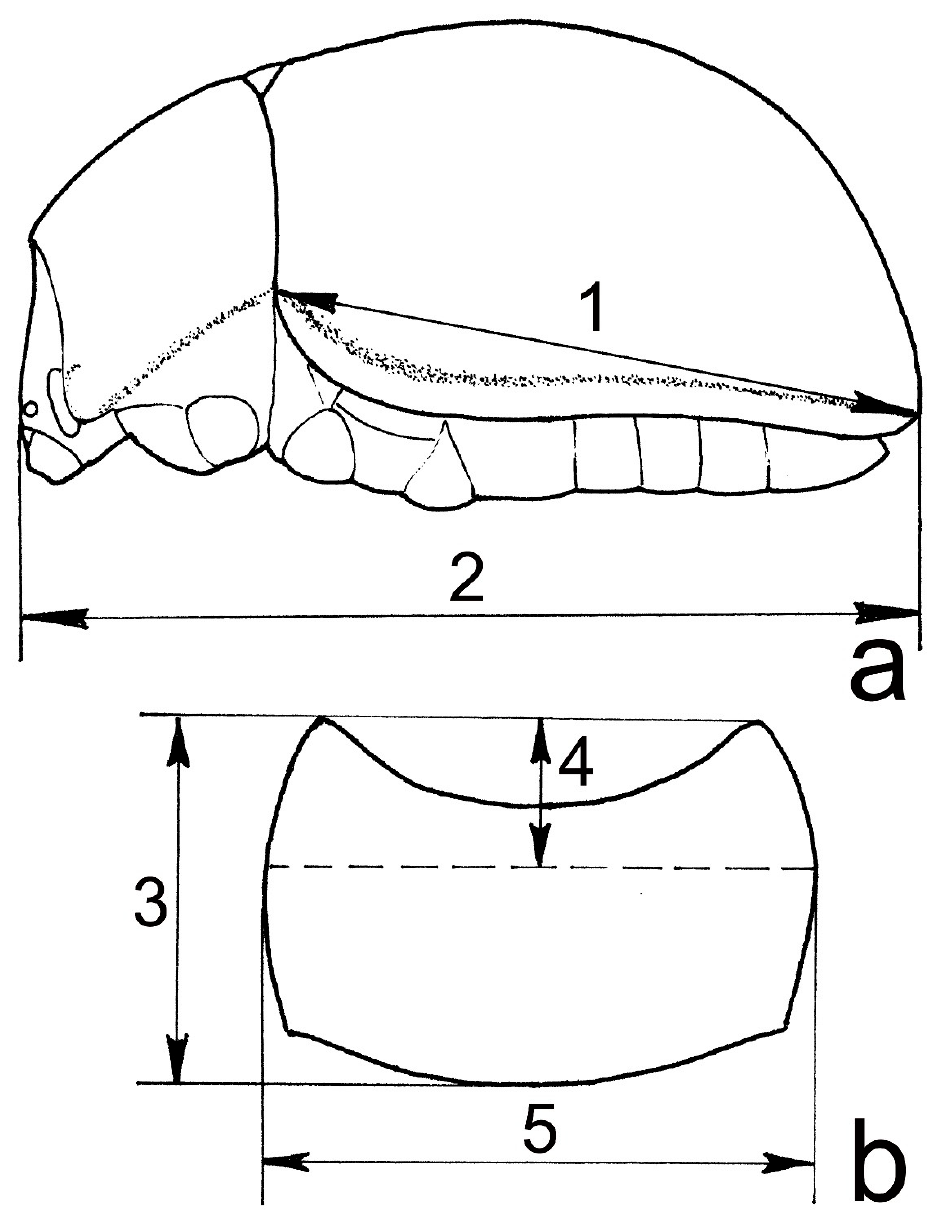
Figure 2. Examined morphological details. ( a ) General lateral view; ( b ) pronotum, dorsal view. Measured characteristics: 1—elytral length, 2—total body length, 3—pronotal length, 4— distance from anterior margin of the pronotum to maximal width, 5—pronotal